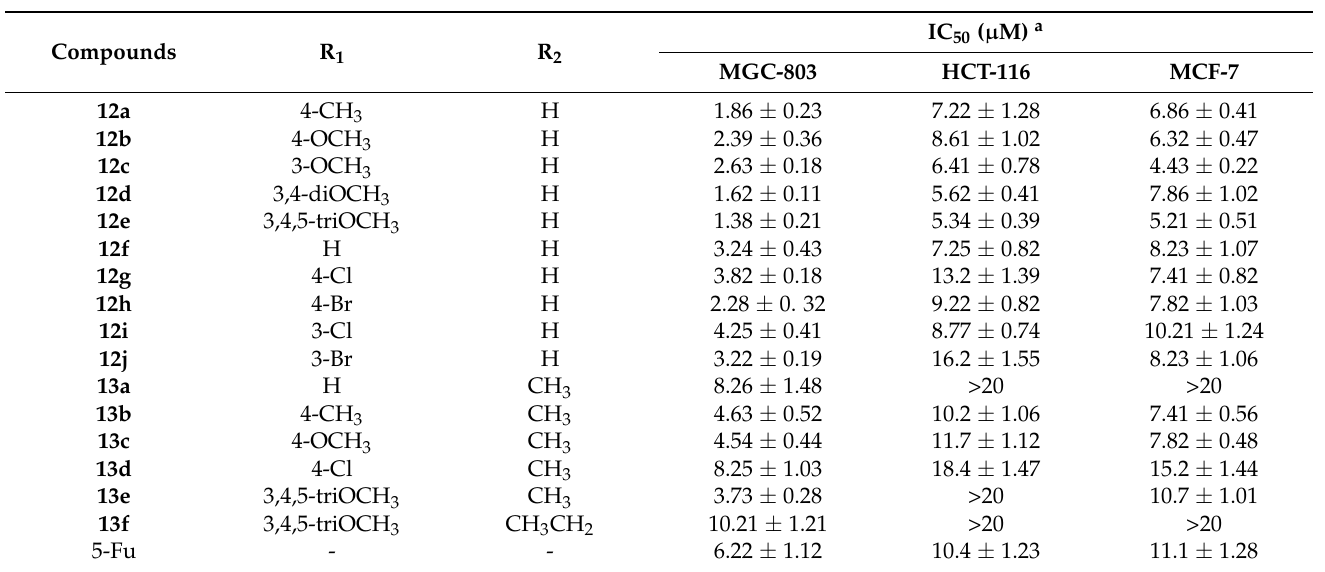
Table 1. In vitro antiproliferative activity of compounds 12a–12j and 13a–13f against MGC-803, HCT-116, and MCF-7 cells.